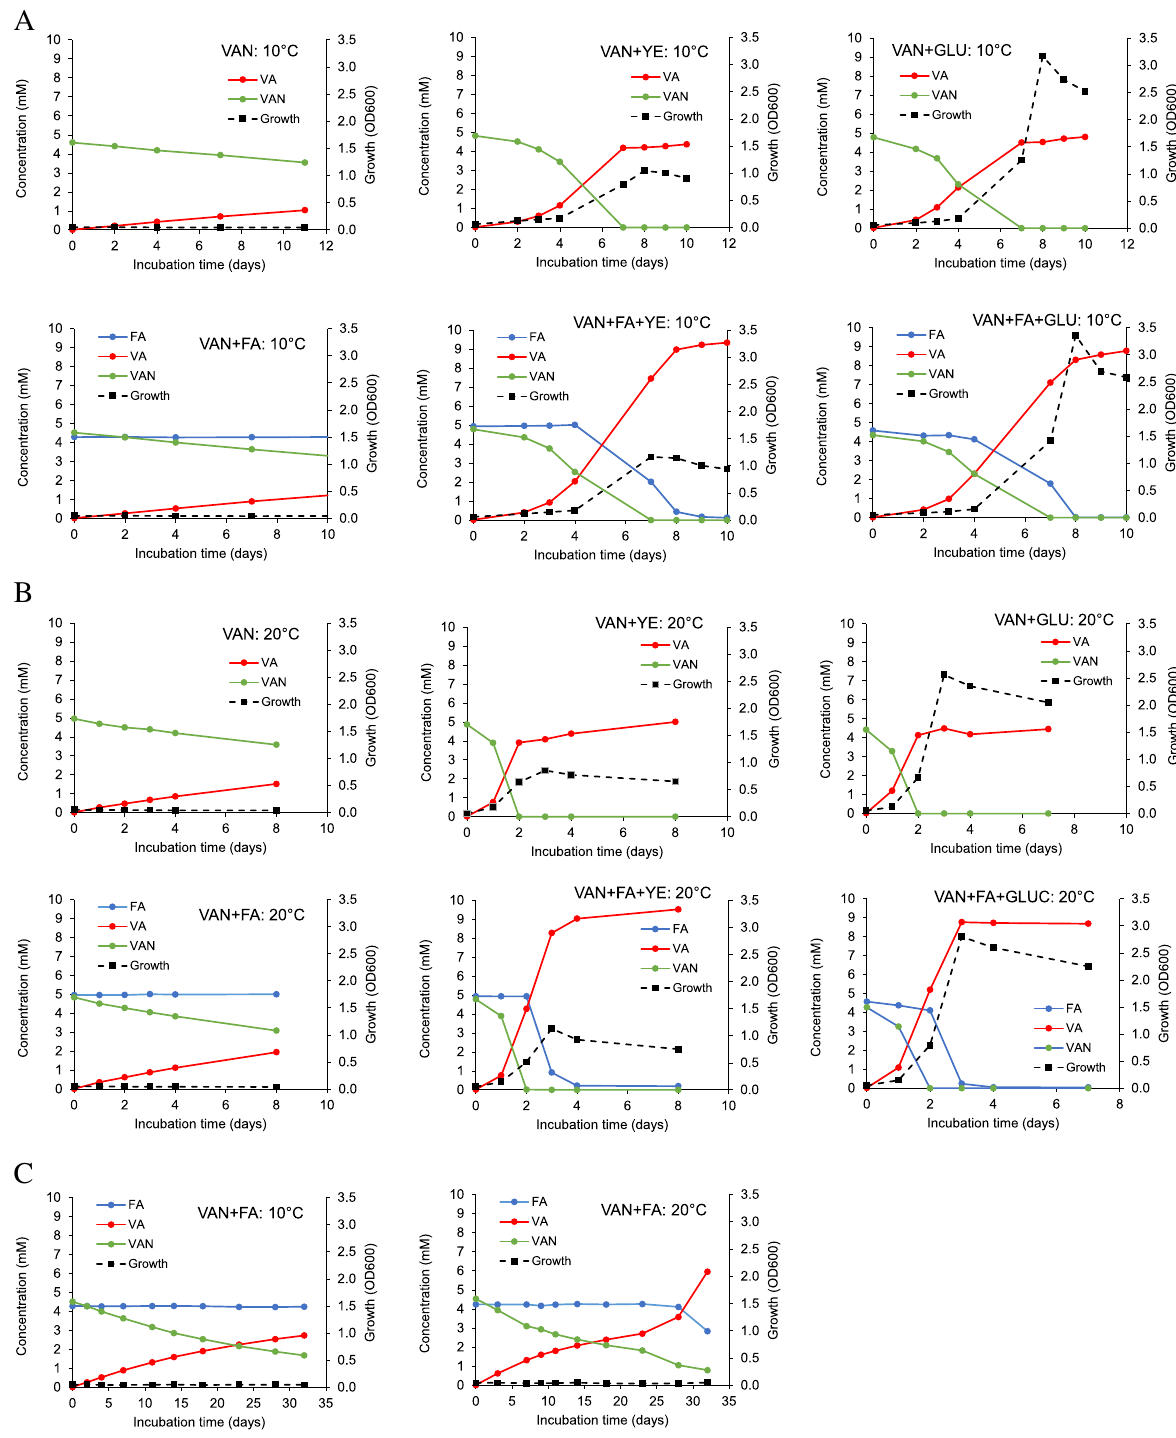
Fig. 8 A Effect of glucose (0.3% w/v) and YE (0.3% w/v) on growth and bioconversion of 5 mM vanillin to VA in the absence (top panels) or presence (bottom panels) of 5 mM FA by P. aromaticivorans AR20-38 at 10 °C. Data represent mean values of three replicates (SDs < 10%). B Effect of glucose (0.3% w/v) and YE (0.3% w/v) on bioconversion of 5 mM vanillin to VA in the absence (top panels) or presence (bottom panels) of 5 mM FA by P. aromaticivorans AR20-38 at 20 °C. Data represent mean values of three replicates (SDs < 10%). C Bioconversion of 5 mM vanillin to VA after 32 days of incubation in the absence or presence of 5 mM FA (in the absence of nutrient supplements) by P. aromaticivorans AR20-38 at 10 °C (left panel) and 20 °C (right panel). Data represent mean values of three replicates (SDs <